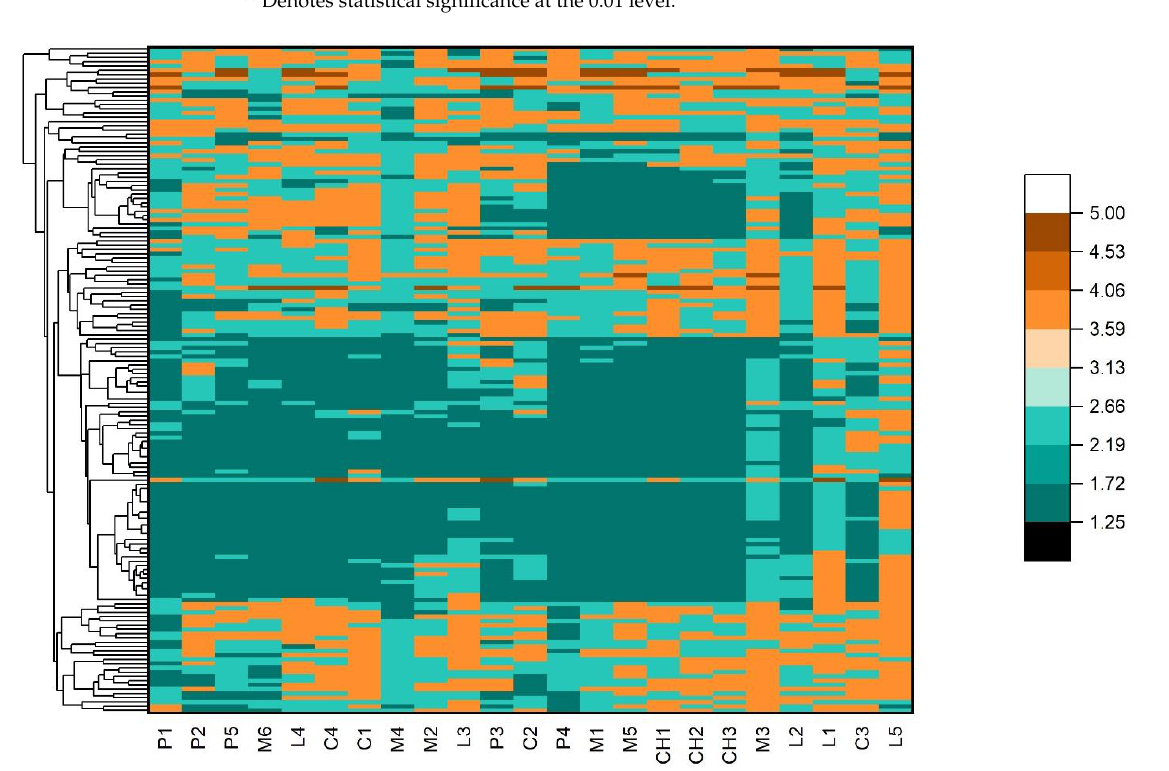
Figure 7. Dendrogram and heat map of the hierarchical cluster analysis of the 23 IPM RPW practices under investigation based on the average scores of the farmers’ adoption.